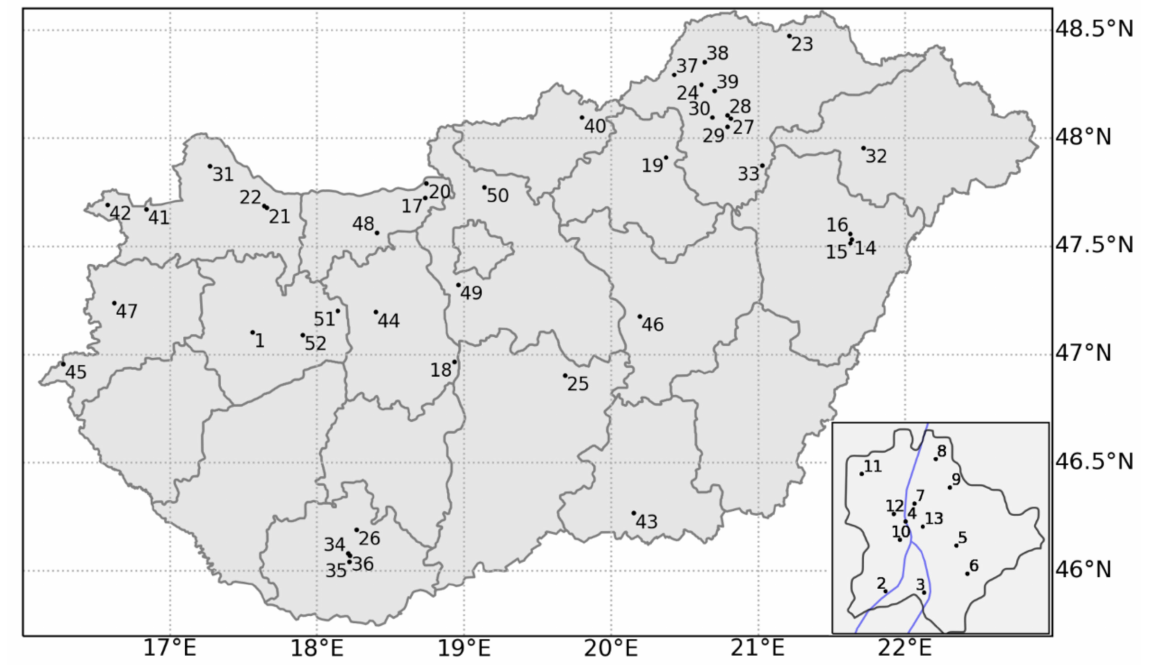
Figure 1. Air pollution monitoring sites in Hungary and the capital city Budapest (lower right). See detailed list in Appendix